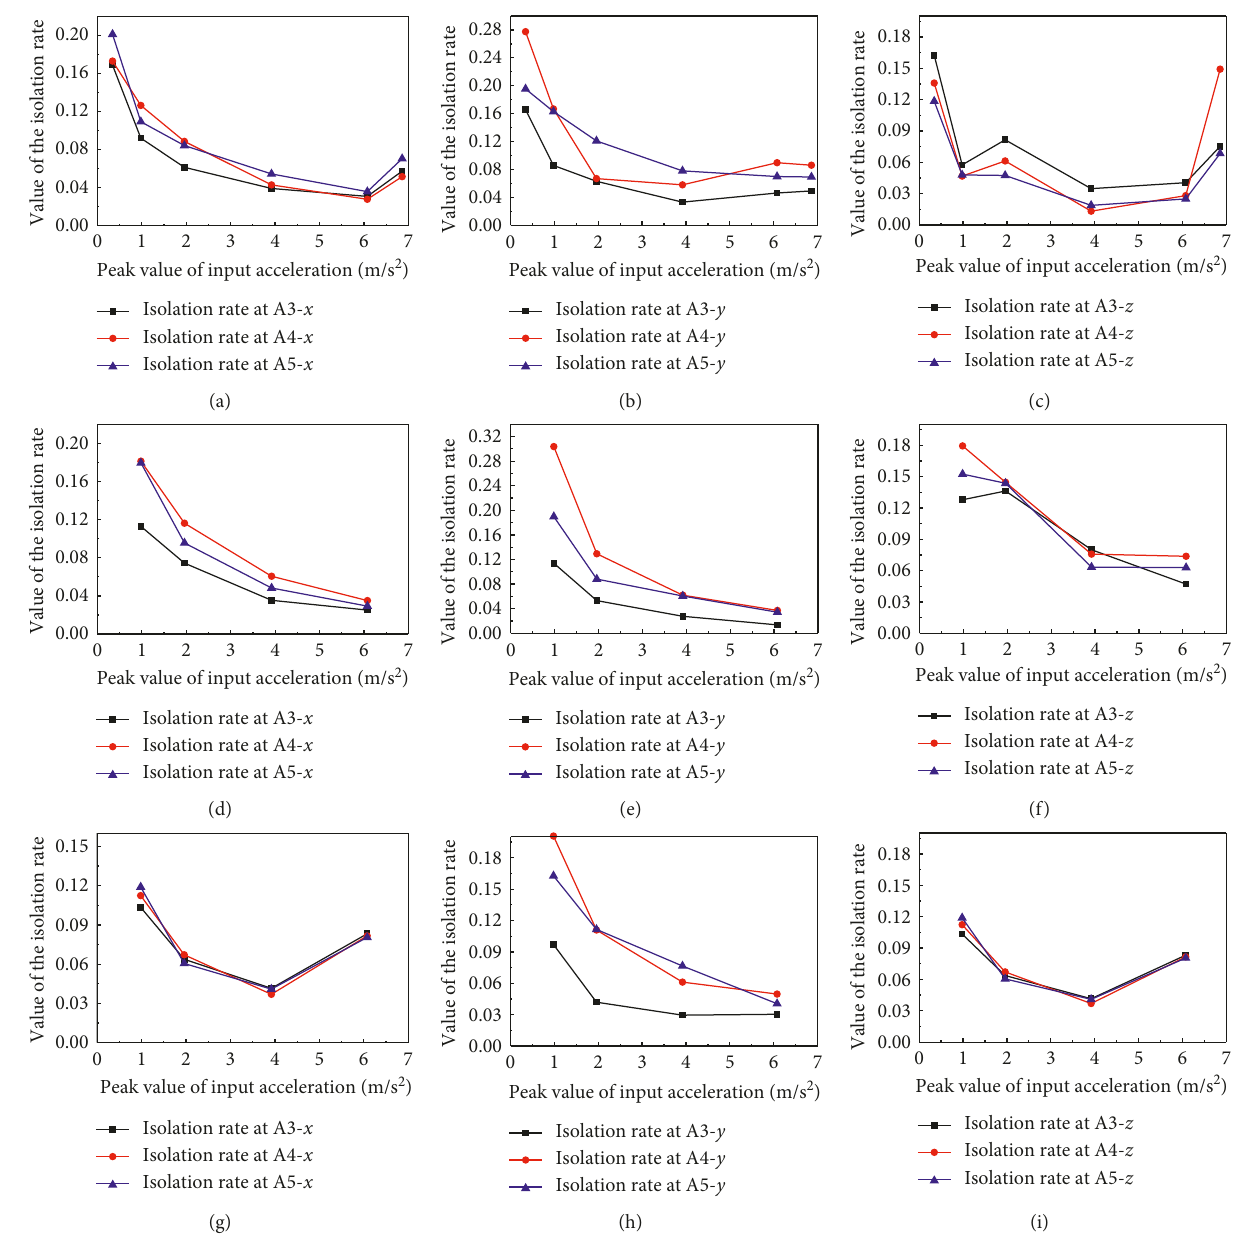
Figure 12: Vibration isolation rate of acceleration. (a) Under Taft seismic motion in the x direction; (b) under Taft seismic motion in the y direction; (c) under Taft seismic motion in the z direction; (d) under 311 seismic motion in the x direction; (e) under 311 seismic motion in the y direction; (f) under 311 seismic motion in the z direction; (g) under Lsfx seismic motion in the x direction; (h) under Lsfx seismic motion in the y direction; (i) under Lsfx seismic motion in the z